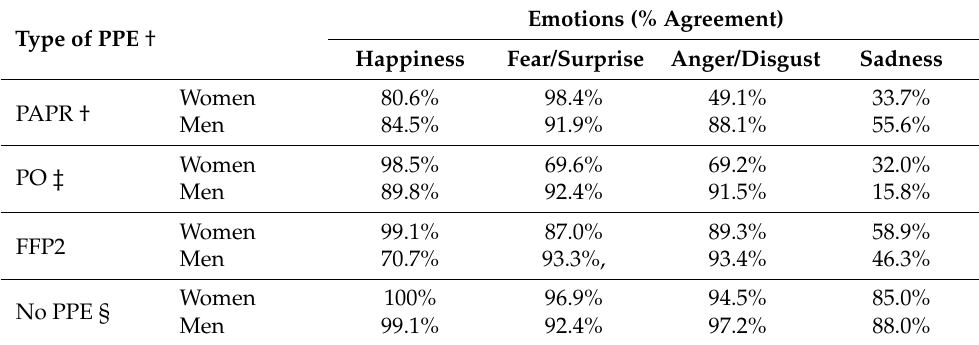
Table 1. The percentage of agreement (success) in identifying the emotions: happiness, fear/surprise, anger/disgust and sadness in the 32 photographs ( n =